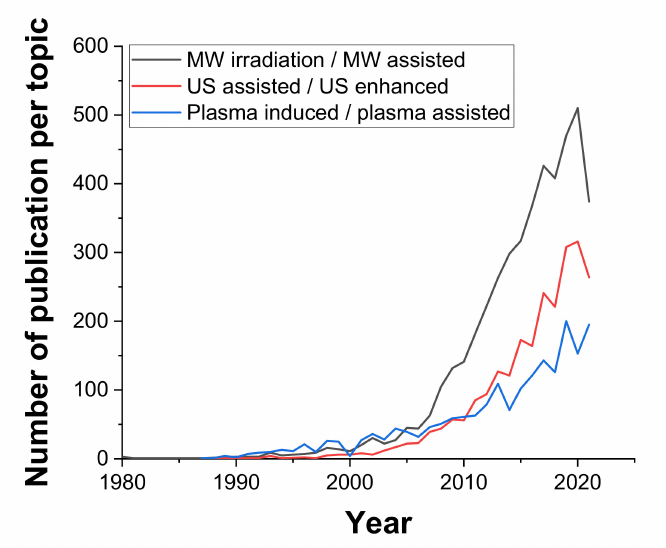
Figure 6. Number of annual articles on the specified topics (MW/US/Plasma) in the field of Chemical engineering; source: Web of knowledge